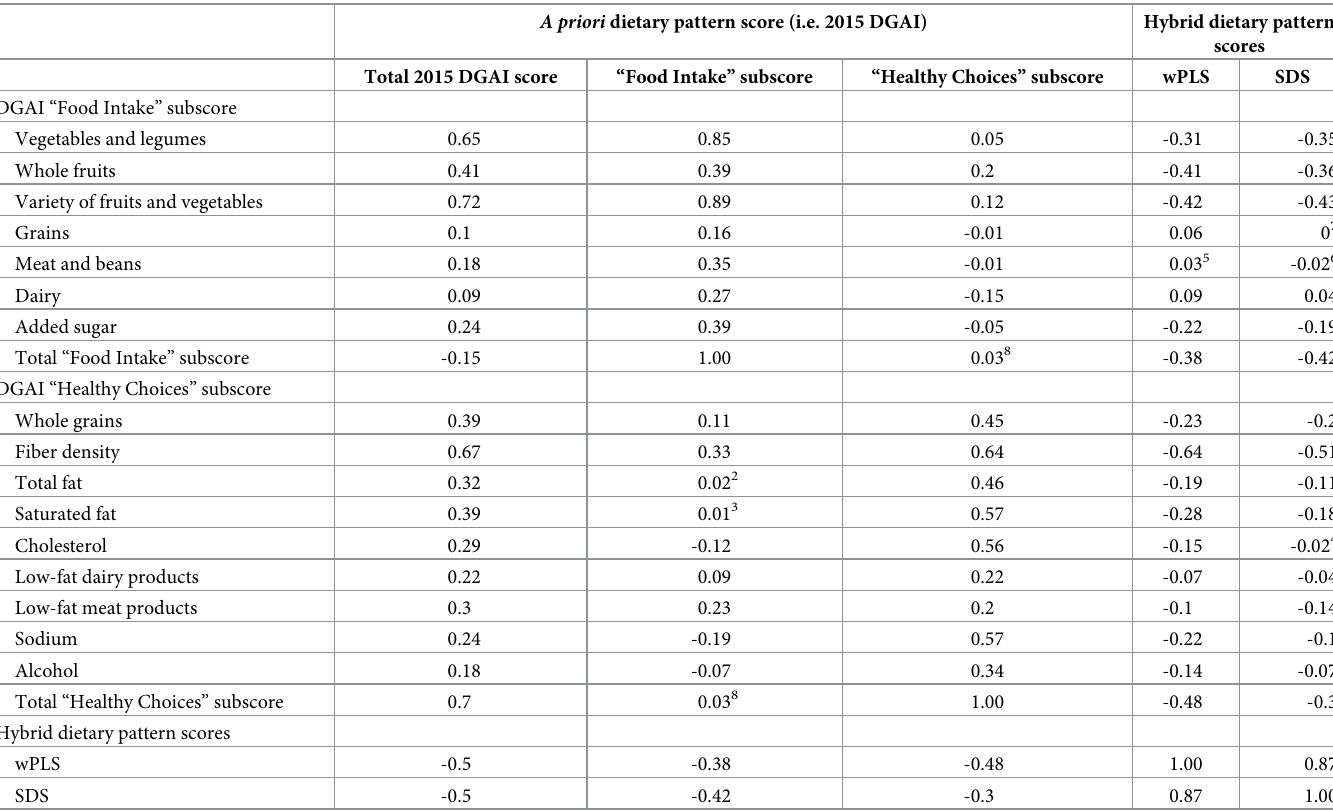
Table 3. Pearson correlation coefficients between components of the 2015 DGAI 1 ; the energy-dense, high-fat and low-fiber density (“obesogenic”) dietary pattern score generated from wPLS; and the simplified dietary pattern score (SDS) among Canadian adults from CCHS-Nutrition 2015 ( n = 12,049). A priori dietary pattern score (i.e. 2015